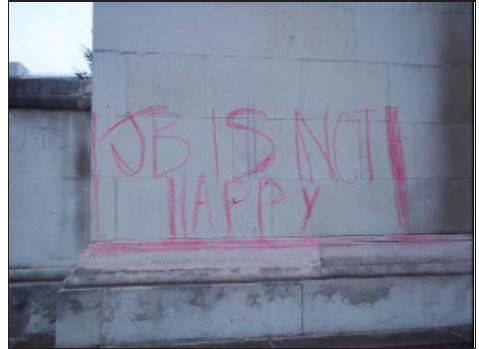
Figure 6: Chalk graffiti on UCL walls dur- ing the students’ protests of 2010 (Photo: Renata F.